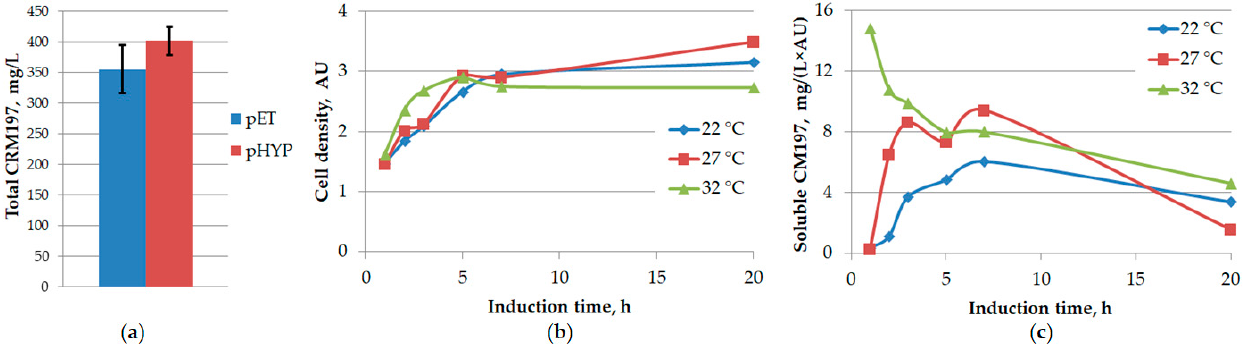
Figure 1. Optimization of CRM197 expression conditions. ( a ) Choosing an expression vector. Total concentration of CRM197 (soluble + insoluble) obtained upon its expression in the E. coli SHuffle T7 strain at 37 °C using pET28a-CRM197-gcc or pHYP-CRM197-gcc expression vectors. ( b ) E. coli SHuffle T7 strain growth in shake flasks at different temperatures during CRM197 expression from the pHYP-CRM197-gcc plasmid. ( c ) Concentration of soluble CRM197 changing over time at dif- ferent temperatures upon CRM197 expression from the pHYP-CRM197-gcc plasmid in the E. coli SHuffle T7 strain in shake flasks. N = 2.